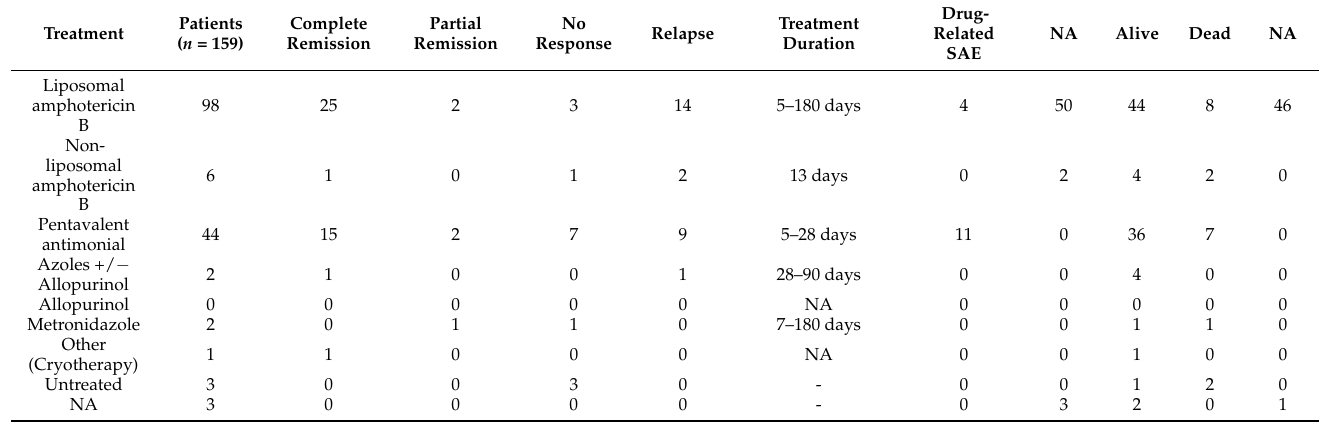
Table 5. Summary of first-line treatment options and treatment-related outcomes of the case reports and case series of Leishmania infection after kidney transplantation (summaries based on individual cases should not be considered as an estimate of the “real world”).